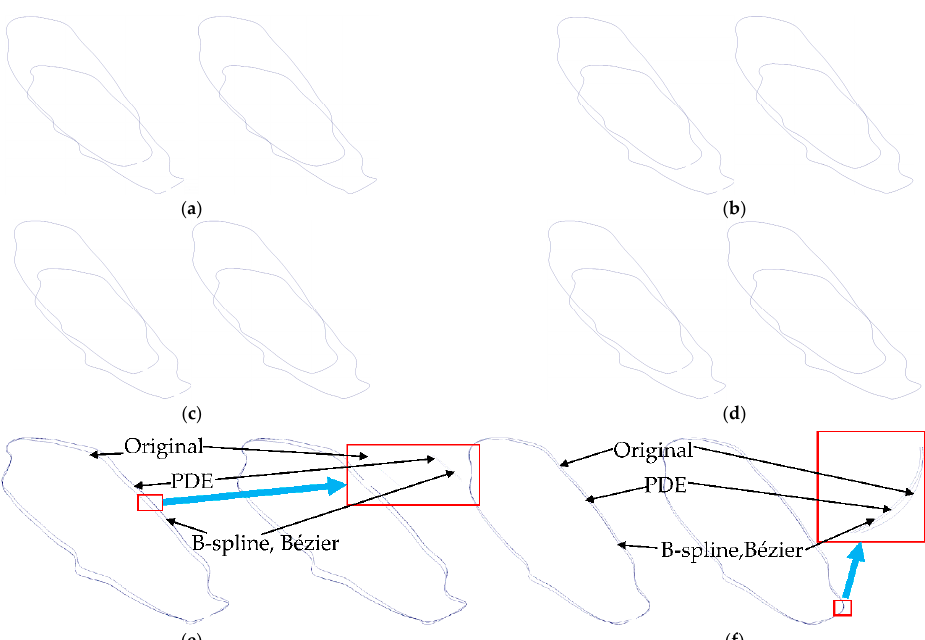
Figure 3. Original and reconstructed curves with 71 points at 20th and 100th frames. ( a ) Original curves at 20th, 100th frames. ( b ) PDE reconstructed curves at 20th, 100th frames. ( c ) B-spline reconstructed curves at 20th, 100th frames. ( d ) Bézier reconstructed curves at 20th, 100th frames. ( e ) Original, PDE, B-spline, and Bézier curves at 20th frame. ( f ) Original, PDE, B-spline, and Bézier curves at 100th frame.